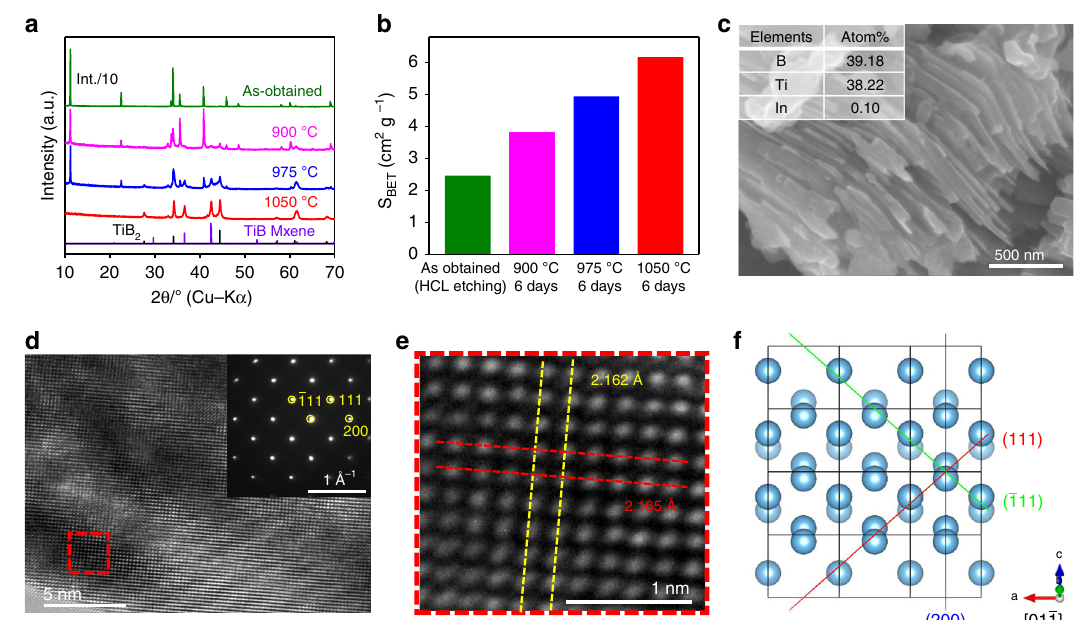
Fig. 4 Structure characterization of layered TiB. a XRD patterns for samples prepared by exposure of as-obtained Ti 2 InB 2 powder to a vacuum (about 10 − 4 Pa) as a function of the temperature after 6 days. b Corresponding speci fi c surface area change of samples in a . c Typical SEM image of the TiB phase obtained at 1050 °C for 6 days under vacuum (about 10 − 4 Pa); inset shows the atomic ratio for this sample. d HRTEM image of the TiB phase along the [01 (cid:1) 1] direction; inset shows the corresponding SAED pattern. e Enlarged HRTEM image from d showing the interlayer spacing for the (111) and ( (cid:1) 111) planes. f Simulated crystal structure of the TiB phase with orthorhombic group ( Cmcm ) along the [01 (cid:1) 1] direction, where the blue spheres represent Ti atoms (other atoms are not